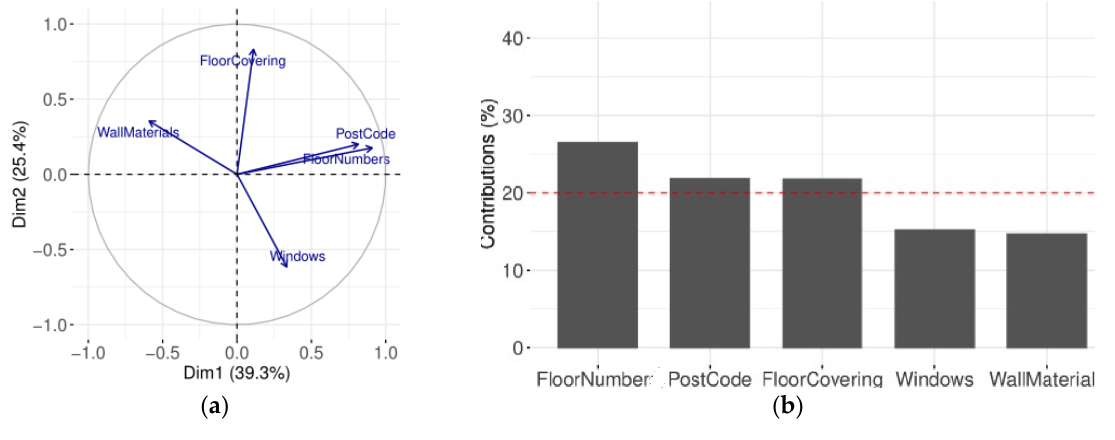
Figure 5. Results of the first PCA analysis : ( a ) the correlation circle and ( b ) percentage contributions of the factors that formed the main components (see Table 1).